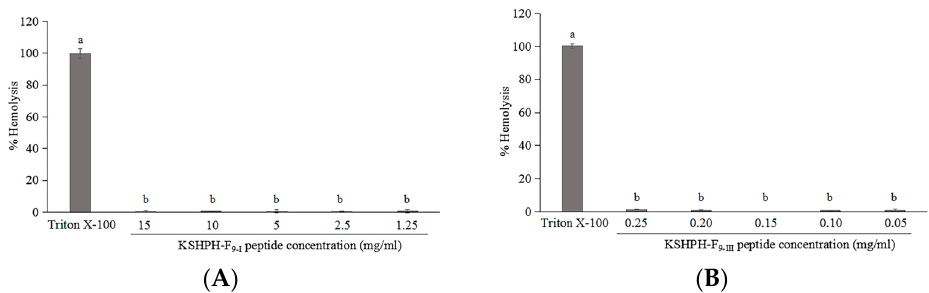
Figure 7. Hemolytic activity of KSHPH − F 9-I ( A ) and KSHPH − F 9-III ( B ) against rabbit red blood cells. Different superscripts note the significant differences ( p < 0.05). All results are average ± SD from three determinations.